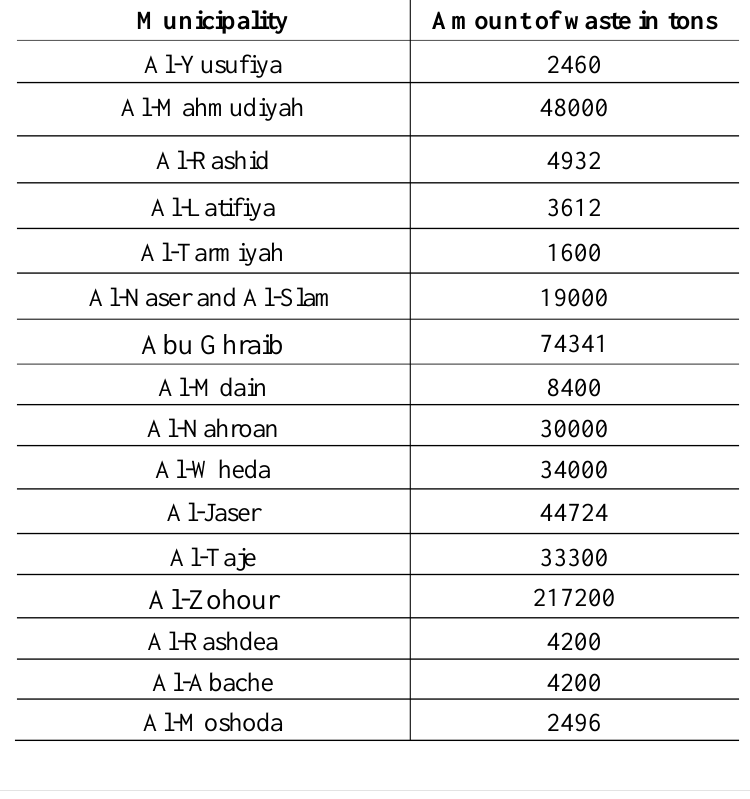
Table 3: The amount of waste produced in